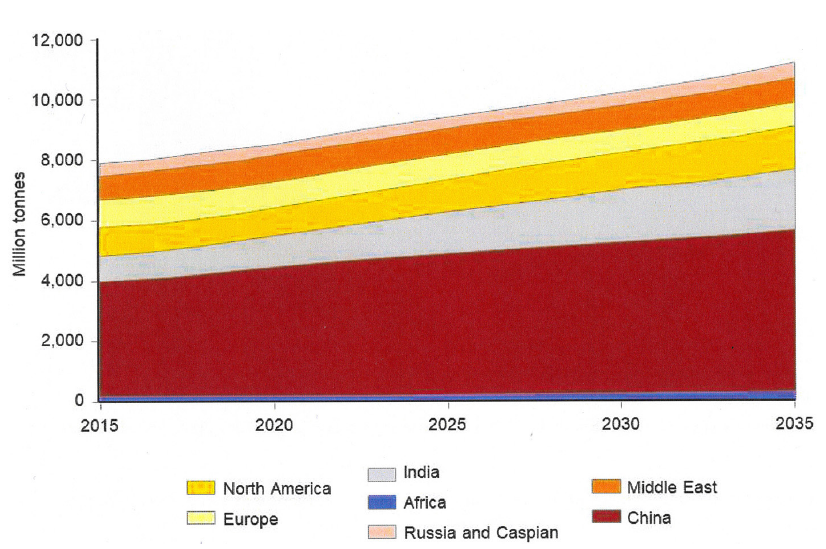
Fig. 10. – World primary energy demand by region, 2015–2035 (Source: Wood Mackenzie, October